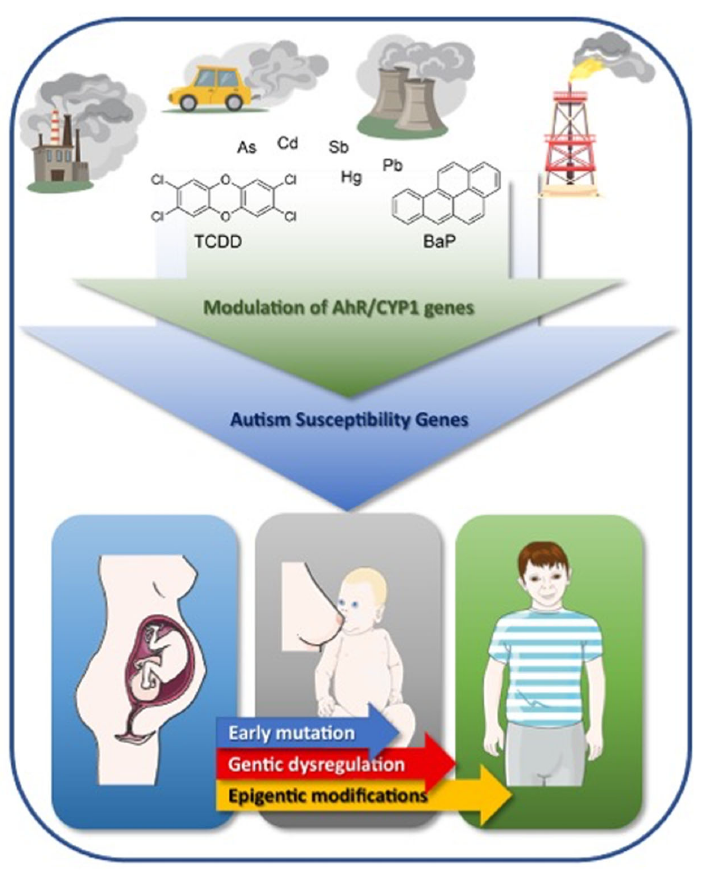
Figure 3. Graphical summary for the impact and mechanisms of environmental pollution in autism development